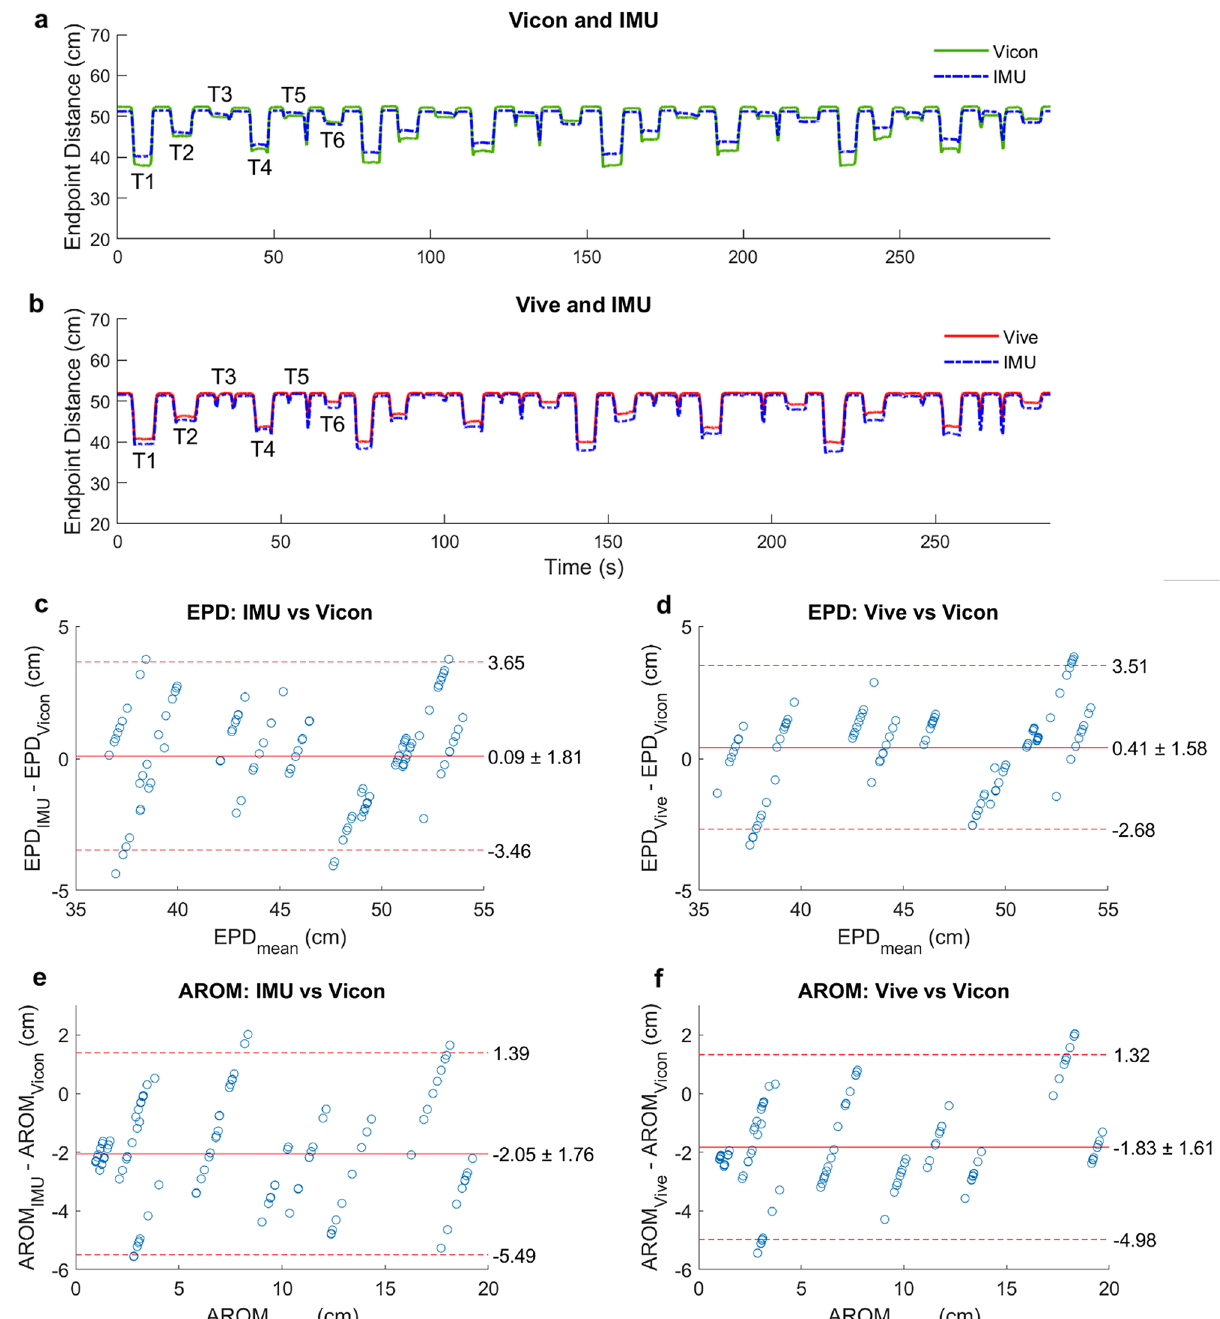
the Vive and IMU ( b ). The plateaus labelled T1 to T6 refer to holding at targets 1 to 6, respectively. ( c – f ) Bland– Altman plots comparing the IMU and Vive’s EPD and active range of motion (AROM) estimations to that of the Vicon. Each circle is from one